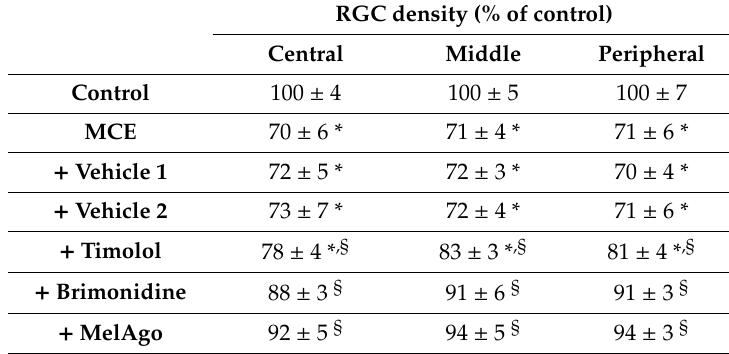
Table 2. E ff ect of timolol, brimonidine, or melatonin / agomelatine on RGC density in central, middle, and peripheral retina. RGC density (% of control) Central Middle Peripheral Control 100 ± 4 100 ± 5 100 ± 7 MCE 70 ± 6 * 71 ± 4 * 71 ± 6 * + Vehicle 1 72 ± 5 * 72 ± 3 * 70 ± 4 * + Vehicle 2 73 ± 7 * 72 ± 4 * 71 ± 6 * + Timolol 78 ± 4 * ,§ 83 ± 3 * ,§ 81 ± 4 * ,§ + Brimonidine 88 ± 3 § 91 ± 6 § 91 ± 3 § + MelAgo 92 ± 5 § 94 ± 5 § 94 ± 3